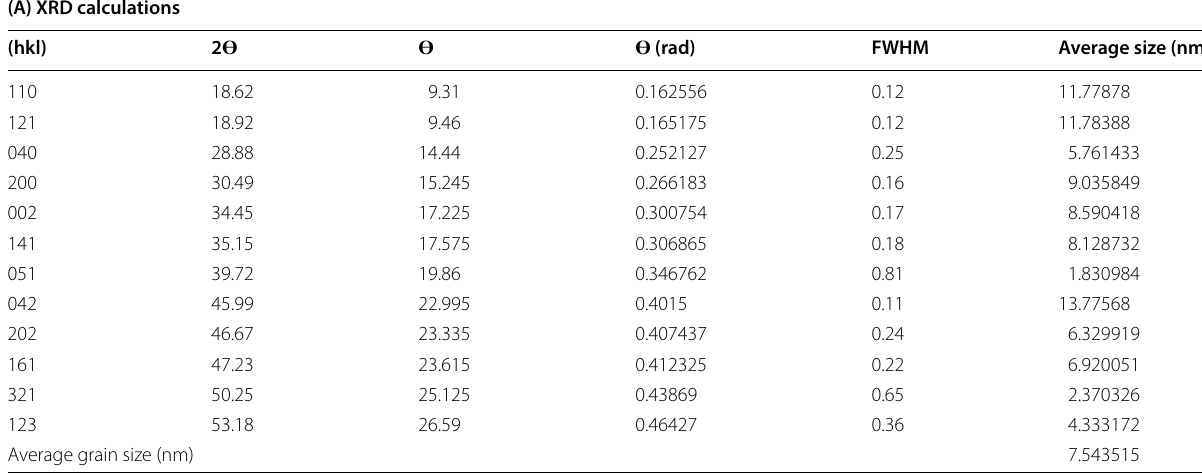
Table 1 A: Major values deduced from XRD data of BiVO of BiVO nanorods 4